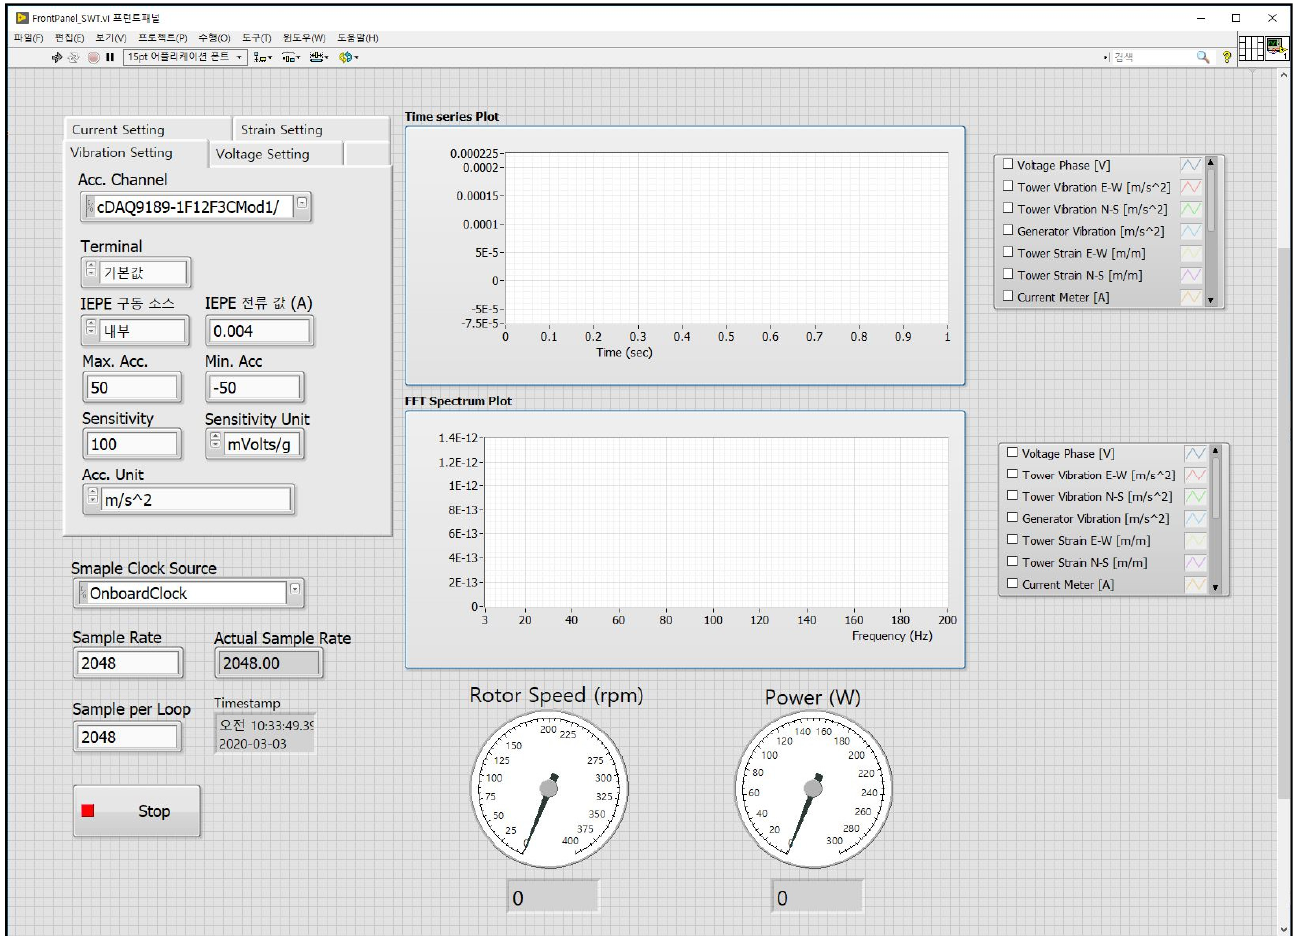
Figure 3. Screenshot of the control program developed by using